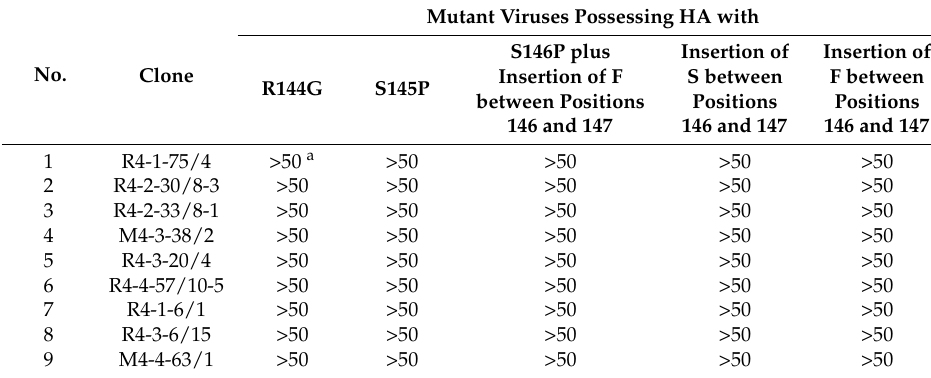
Table 7. Neutralizing activity of the human mAbs against the escape mutant viruses.